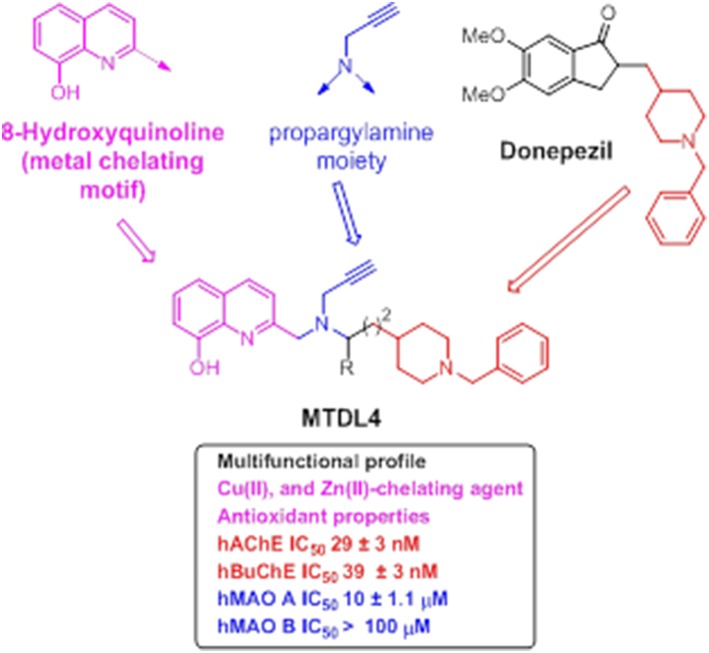
Structure of hybrid MTDL-4 and IC50 values for the inhibition of ChEs and MAO enzymes (Wu et al., 2015).